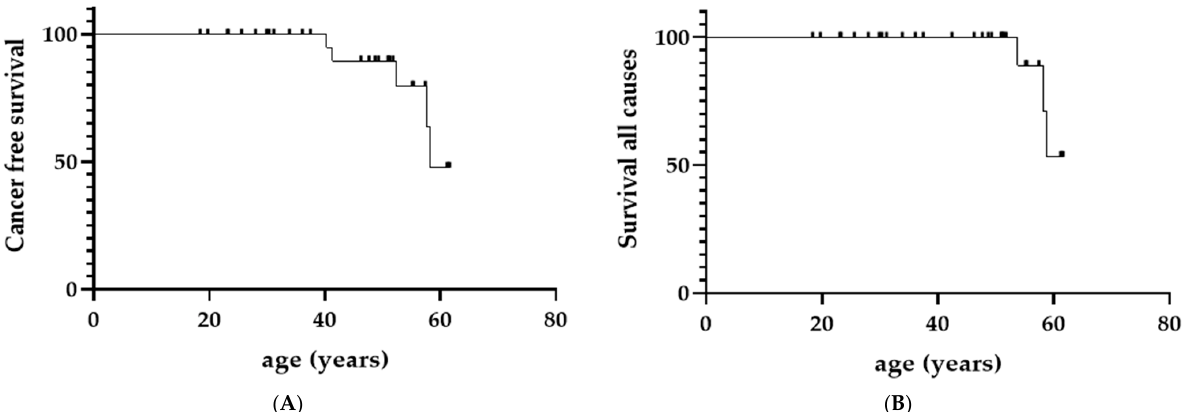
Figure 1. Kaplan–Meier survival probability curve in CV-ASMD (chronic visceral ASMD). ( A ) Survival age without cancer ( n = 5 events); ( B ) Survival age considering all causes of death ( n = 3 events).